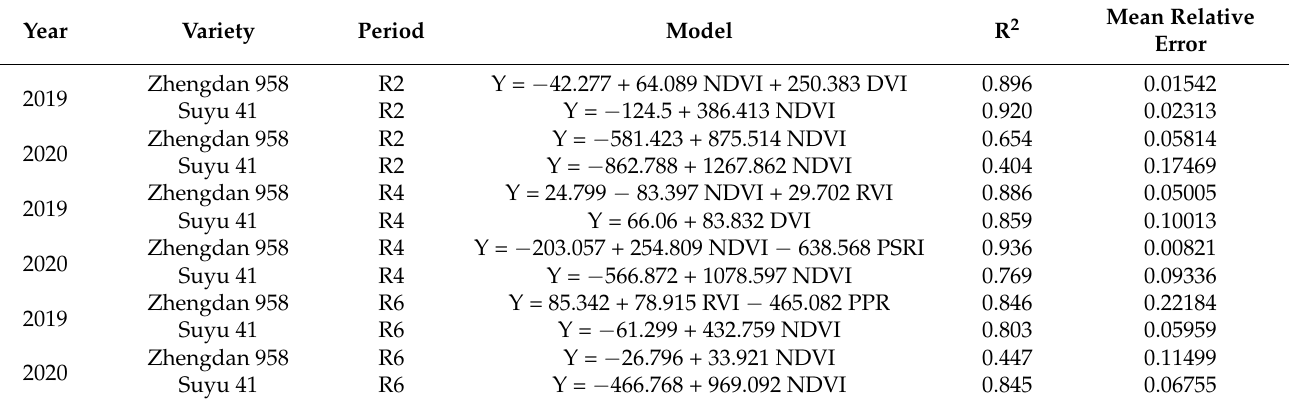
Table 8. Construction of protein-content-prediction model for different growth stages of Zhengdan 958 in 2019 and